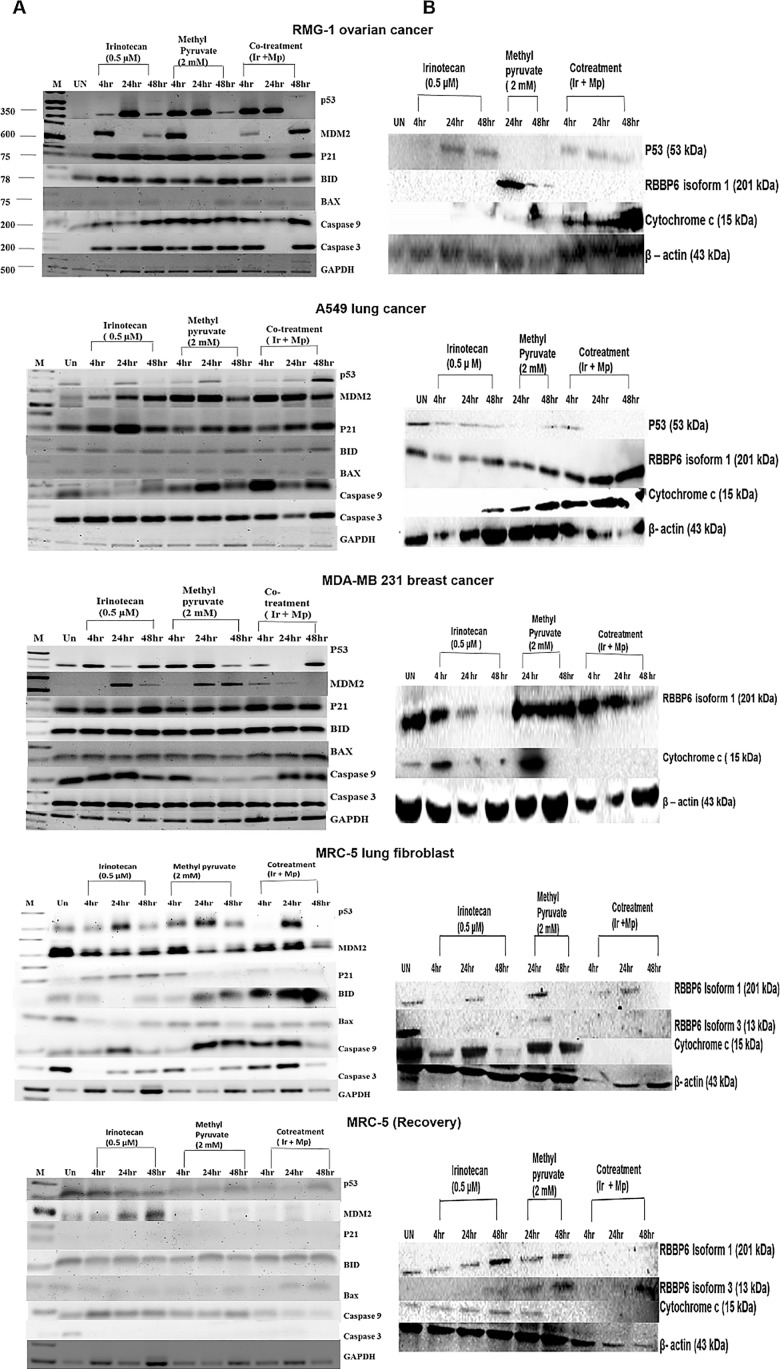
Analysis of apoptotic pathways.(a) RT-PCR shows changes in transcription of p53, MDM2, p21, BID, Bax, caspase 9, and caspase 3 after 4 hours, 24 hours and 48 hours treatment with 2 mM methyl pyruvate in the presence and absence 0.5 μM irinotecan in RMG-1, A549, MDA-MB 231, and MRC-5 cells including MRC-5 cells during the recovery period. Glyceraldehyde 3-phosphate dehydrogenase (GAPDH) was used as a loading control. Semi-quantitative analysis in S2 Fig. (b) Western Blot analysis showing changes in expression of p53, RBBP6 and cytochrome c proteins in RMG1, A549, MDA-MB 231, and MRC5 cell lines after treatment as indicated. Again MRC5 cells were allowed to recovery for a further 24 hours after each treatment. Actin was used a loading control. Densitometry semi-quantitative analysis shown in S3 Fig.